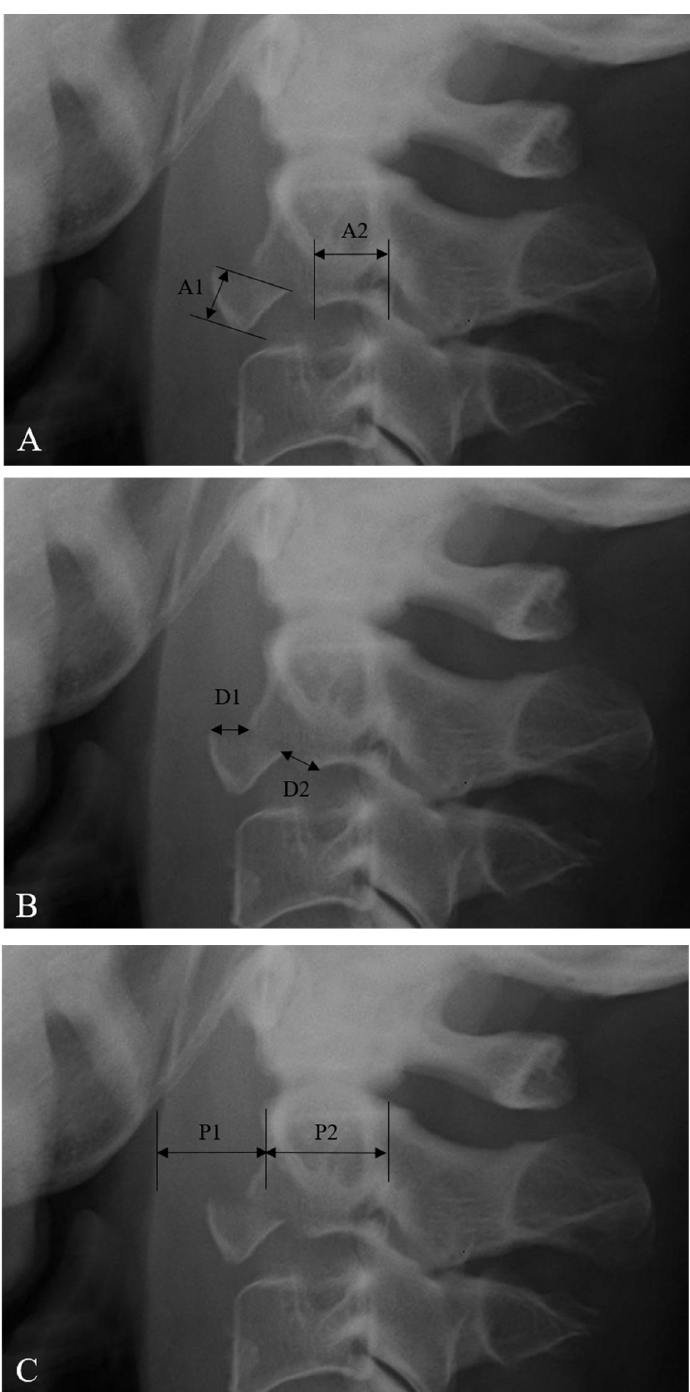
Figure 1. ( A ) The method of measuring the avulsion fracture ratio of anterior C2 (2nd cervical vertebra) tear drop (TD) fractures. The sagittal diameter of the inferior C2 endplate includes A1 and A2 (inferior endplate diameter of C2 TD fragment (A1) and remaining C2 body (A2)). Avulsion ratio of anterior C2 TD fracture = A1/(A1 + A2) × 100%. ( B ) The method of measuring the fracture displacement of anterior C2 TD fractures. The displacement of the fragment is measured at the superior point (D1) and the posteroinferior point (D2). Fracture displacement of anterior C2 TD fracture = (D1 + D2)/2. ( C ) The method of measuring the prevertebral soft tissue thickness (PSVT). The sagittal diameter of PSVT (P1) and C2 body (P2) is measured at the C2 body midpoint. Ratio of PSVT at anterior C2 TD fracture = P1/P2.